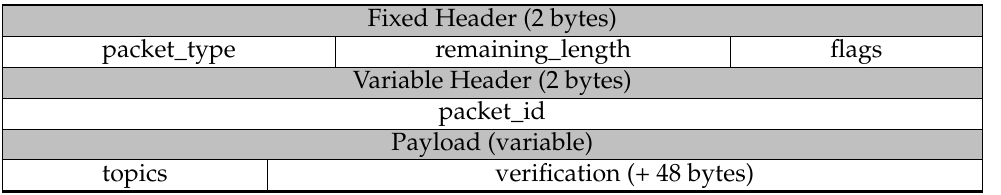
Table 3. MQTT modified subscribe packet.